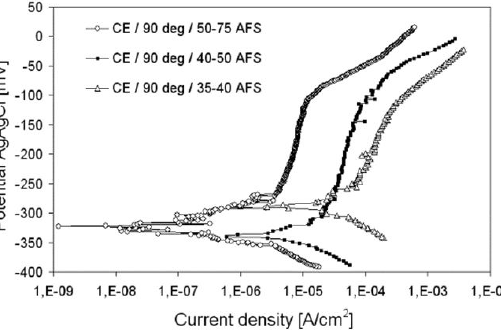
Figure 8. Potentiodynamic curves obtained for AISI 304L steel in erosion-corrosion tests with 3.5% NaCl solution, 90º, 6.5 m/s and different particle size.